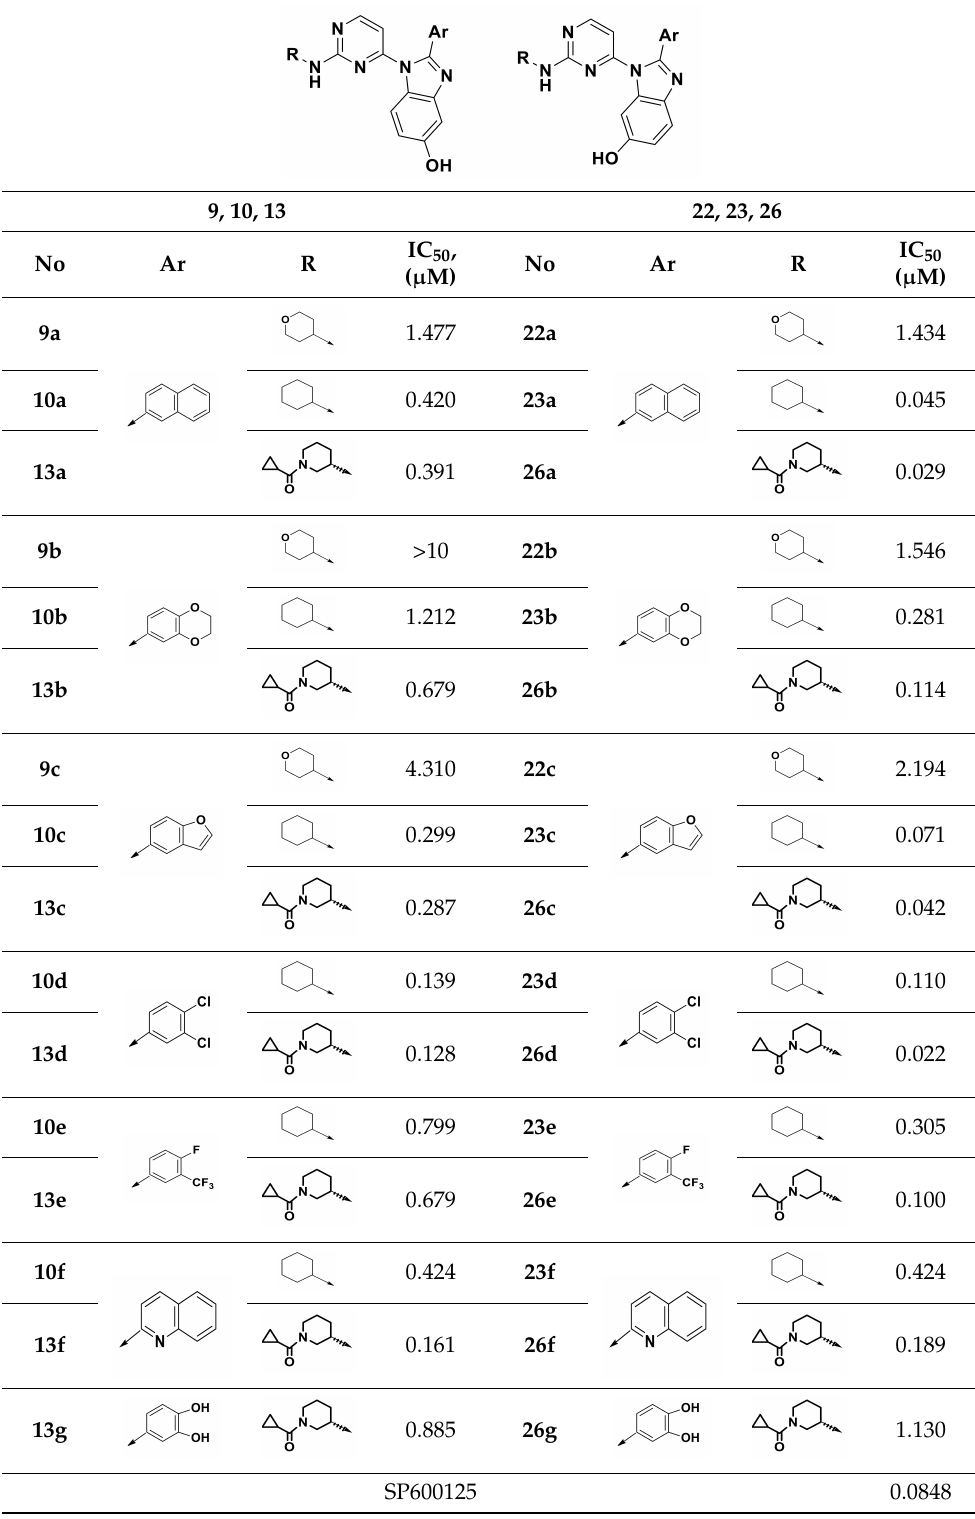
Table 1. JNK3 inhibitory activity (IC 50 ) of compounds 13a - 13s , 26a - 26s